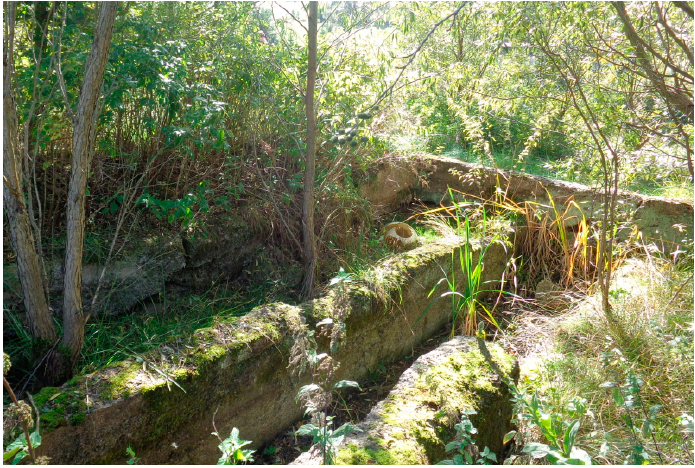
Figure 7. Concrete remains of the presumed cesspool, AL Kaltwasser; photo P. Lewandowski.